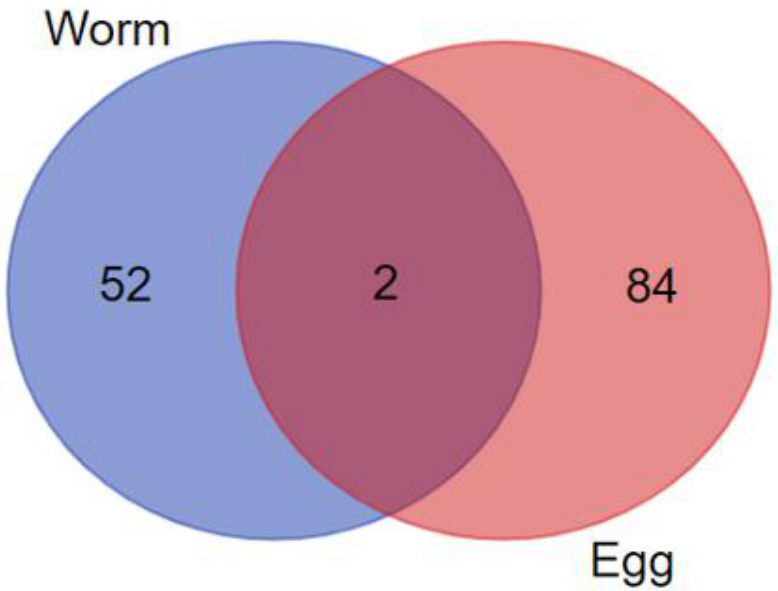
Figure 4. Venn diagram of S . mekongi adult worm and egg peptidomes identified by mass